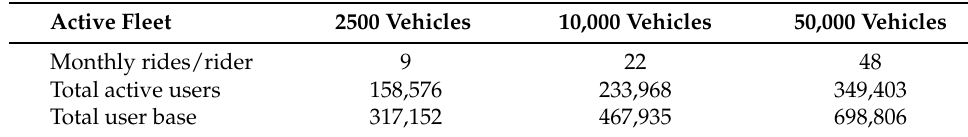
Table 5. Parameters related to riders and user